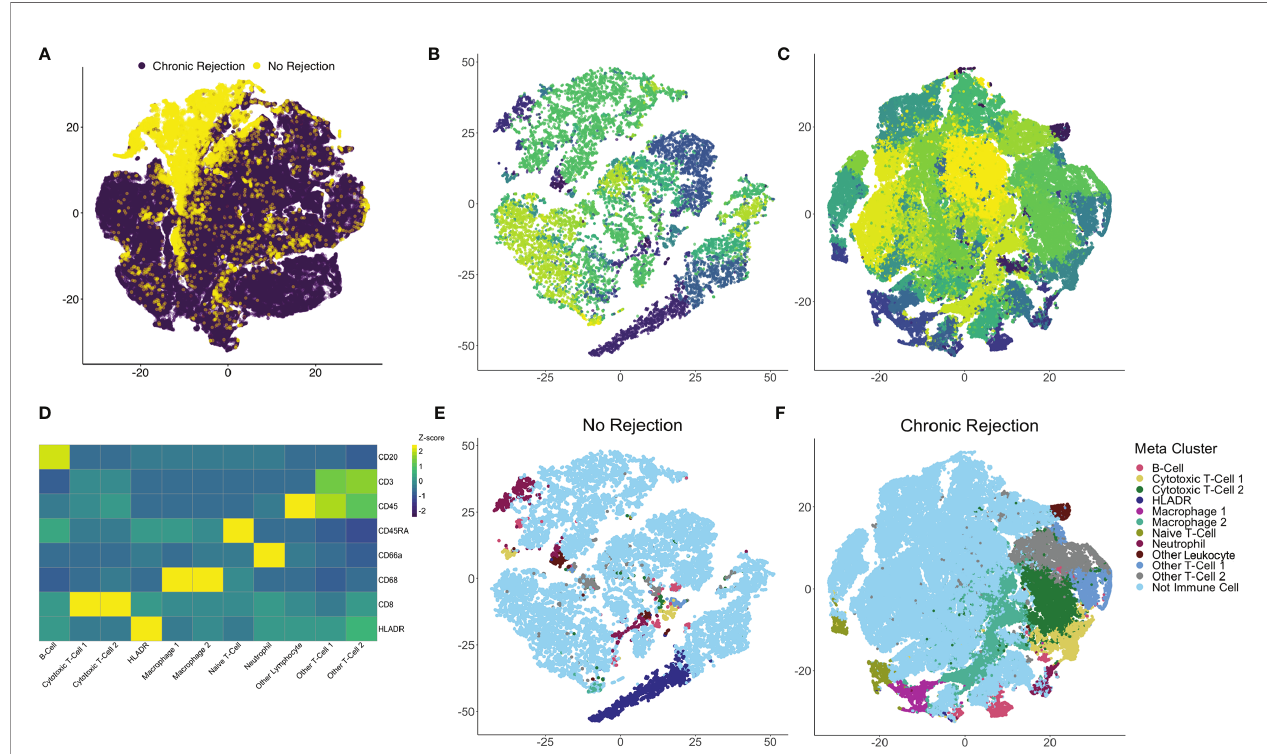
FIGURE 3 | Identi fi cation of individual immune subpopulations present in high-dimension histopathological analysis of clinical liver transplant rejection. (A) T- distributed stochastic neighbor embedding (tSNE) plots of 109,245 individual cells identi fi ed using IMC of liver with no rejection (purple, 16,454 cells) and chronic rejection (yellow, 92,791 cells) were created to compare the two patient cohorts, revealing global differences in cellular meta-clusters. Next, Phenograph plots were created for cells identi fi ed in liver tissue to identify immune meta-clusters. Among 29 total cellular meta-clusters identi fi ed through the combined dataset of liver with no rejection (B) versus chronic rejection (C) , 11 had at least one immune marker present. Immune meta-clusters were then applied back to tSNE plots for no rejection (E) and chronic rejection (F) to visualize density and distribution of immune subpopulations of interest. To further characterize these immune subpopulations, a heatmap of column-standardized median marker intensity for each immune meta-cluster was created to associate individual markers with cellular phenotypes (panel D, color scale represents z-scores for each